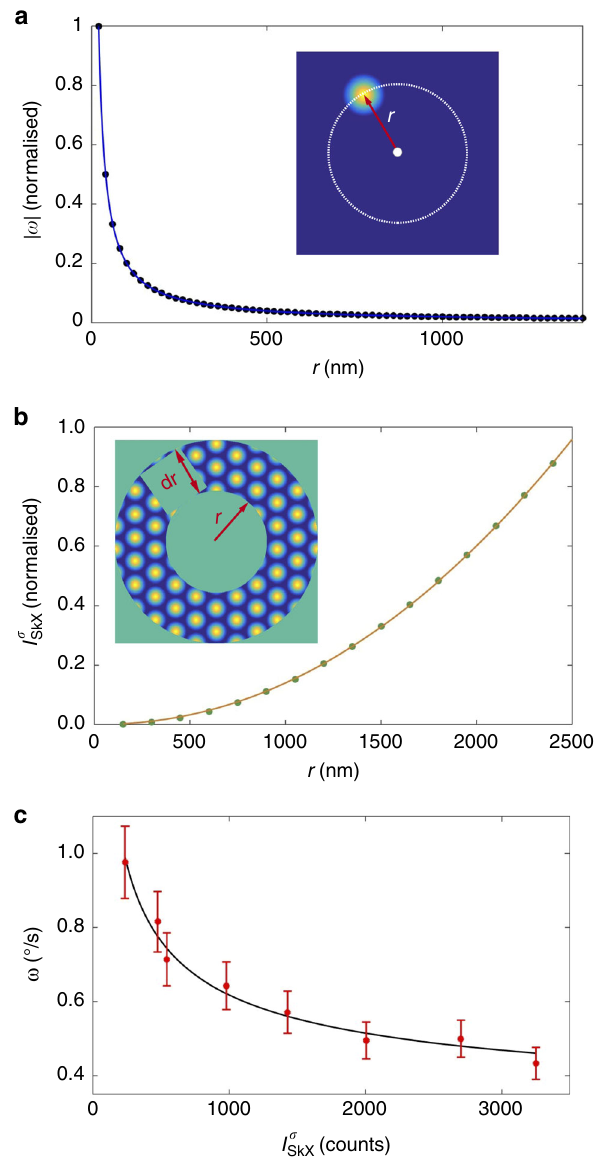
Fig. 4 Universal velocity – radius relation for fi eld gradient-induced skyrmion rotation. a Simulated angular velocity ( ω ) plot as a function of the distance of the rotating skyrmion from the centre ( r ) (shown as blue dots). The dependency follows a ω ~ r − 1 relationship (blue line). b The calculated REXS intensity (using σ -polarised X-rays) shows a quadratic dependence on the track radius r (track width d r ). The green dots are the numerical calculation (cid:5) r 2 (orange line). c From the REXS results, which are best fi tted with I σ SkX data, the angular velocity ω of the rotating skyrmion track, and the resulting diffraction intensity I σ , can be acquired (red dots). The error bars SkX represent the standard deviation from the mean value of the angular Þ relation is in excellent velocity, averaged over 1000 s. The measured ω ð I σ SkX − 1/2 agreement with the theoretical results, which predict ω (cid:5) I σ SkX